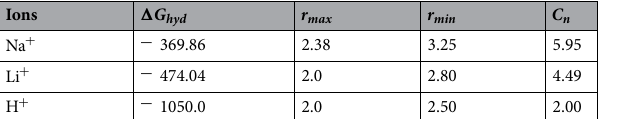
Table 1. Hydration properties of Na + , Li + , and H + ions in bulk-liquid water. (cid:31) G hyd (kJ/mol), hydration energy of ion in bulk-water from Ref. 66,67 ; r max and r min (Å), location of the first maximum and minimum of ion-water g(r); C n , coordination number 68,69